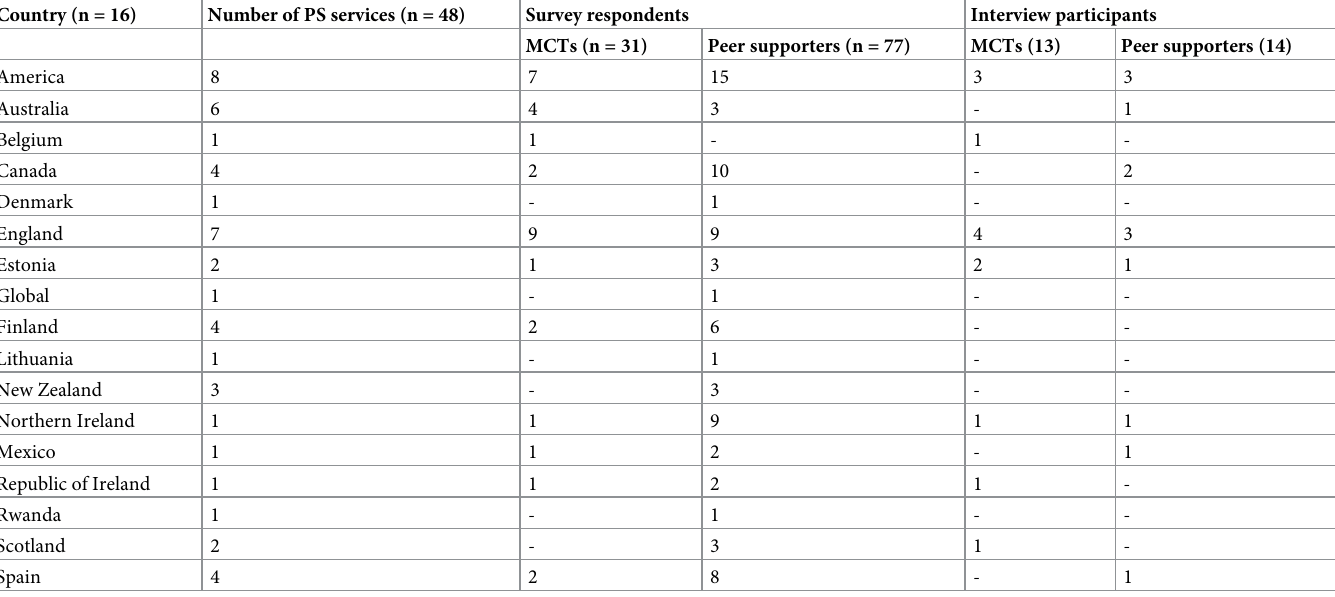
Table 2. Overview of numbers of participants and types of participation by country of PS